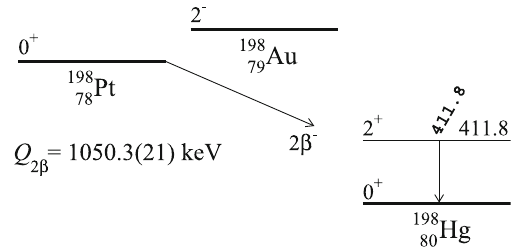
Fig. 2 A simplified decay scheme of 198 Pt [30]. The energies of the excited level and of the emitted γ quantum are in keV. Q 2 β is the double-beta decay energy of 198